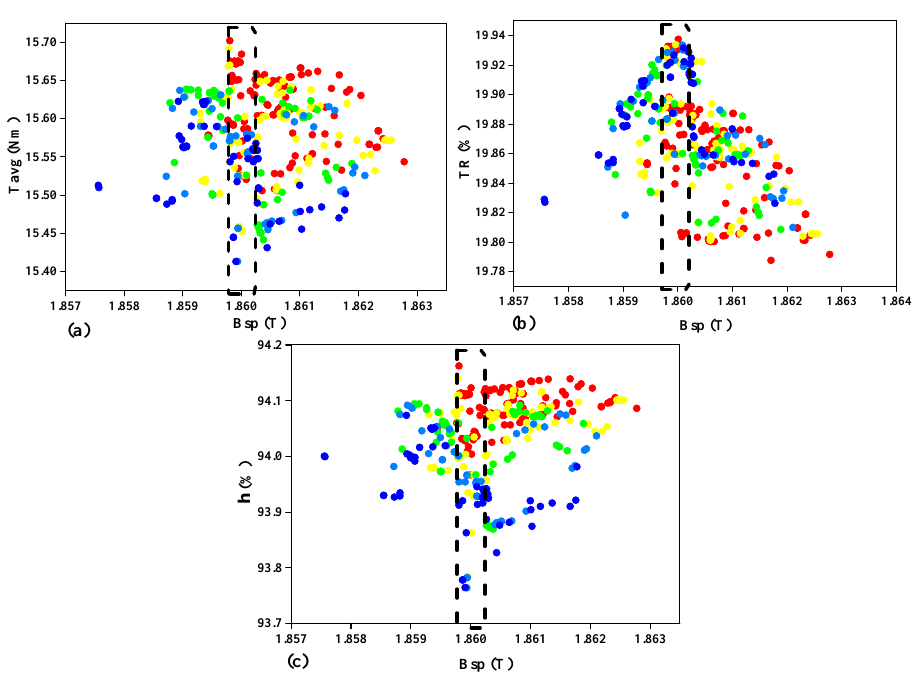
Figure 13. Tradeoff plot of output variables with B sp ( a ) T avg with B sp ( b ) TR with B sp ( c ) η with B sp . The output solutions highlighted in the dashed-line box dominate other solutions in the white areas since they are generated around 1.86 T . The best to worst solutions go from red to